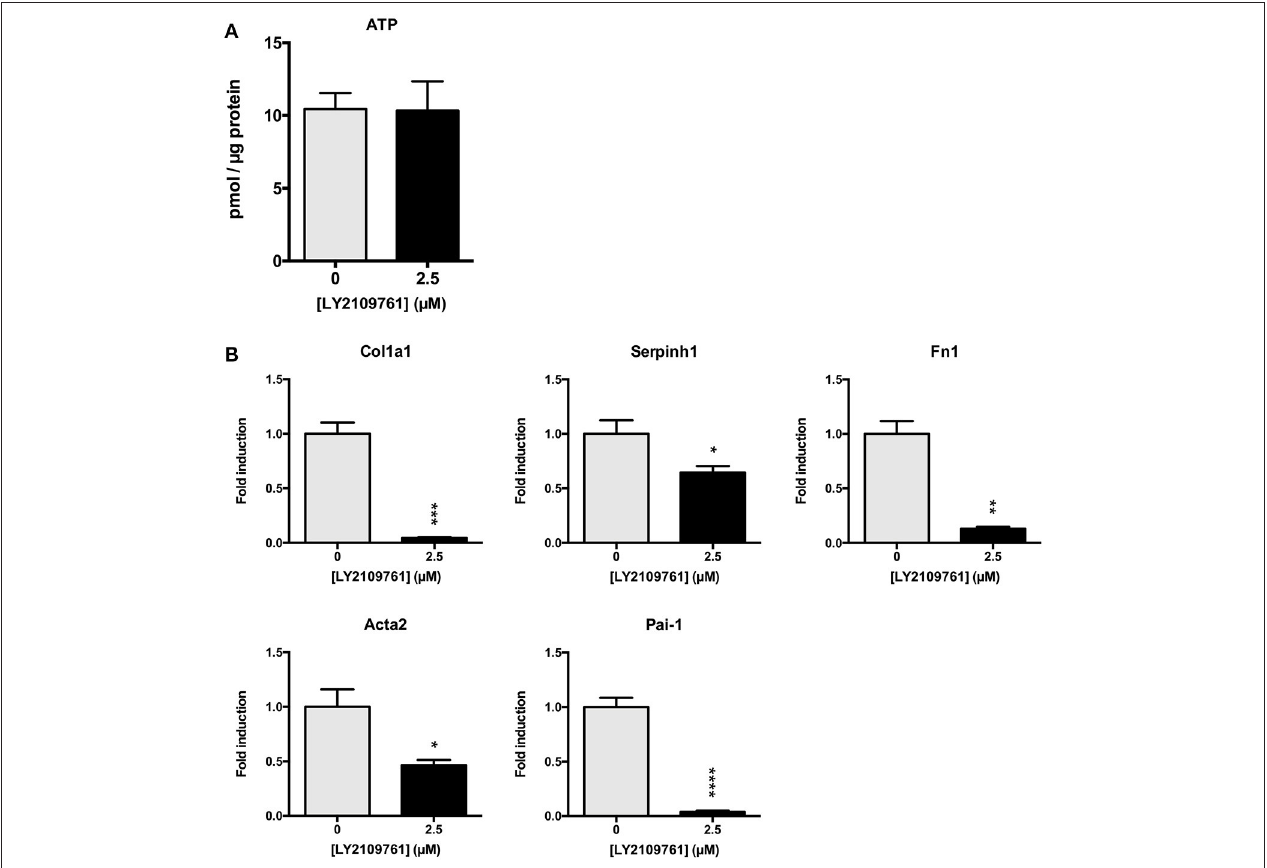
FIGURE 4 | TGF- β receptor inhibition in mPCKS by LY2109761. (A) Viability of slices treated with LY2109761 compared to 48h control. (B) Reduction of fibrosis gene expression (Col1a1, Acta2, Serpinh1, Fn1) in slices treated with LY2109761 for 48h. * p < 0.05, ** p < 0.001, *** p < 0.001, **** p < 0.0001. Data is expressed as mean ( ± SEM), n = 4–5. mPCKS, murine precision-cut kidney slices; Col1a1, collagen type I alpha 1; Serpinh1, serine proteinase inhibitor clade H (Heat Shock Protein 47) member 1; Fn1, fibronectin 1; Acta2, alpha 2 smooth muscle actin; Pai-1, Plasminogen activator